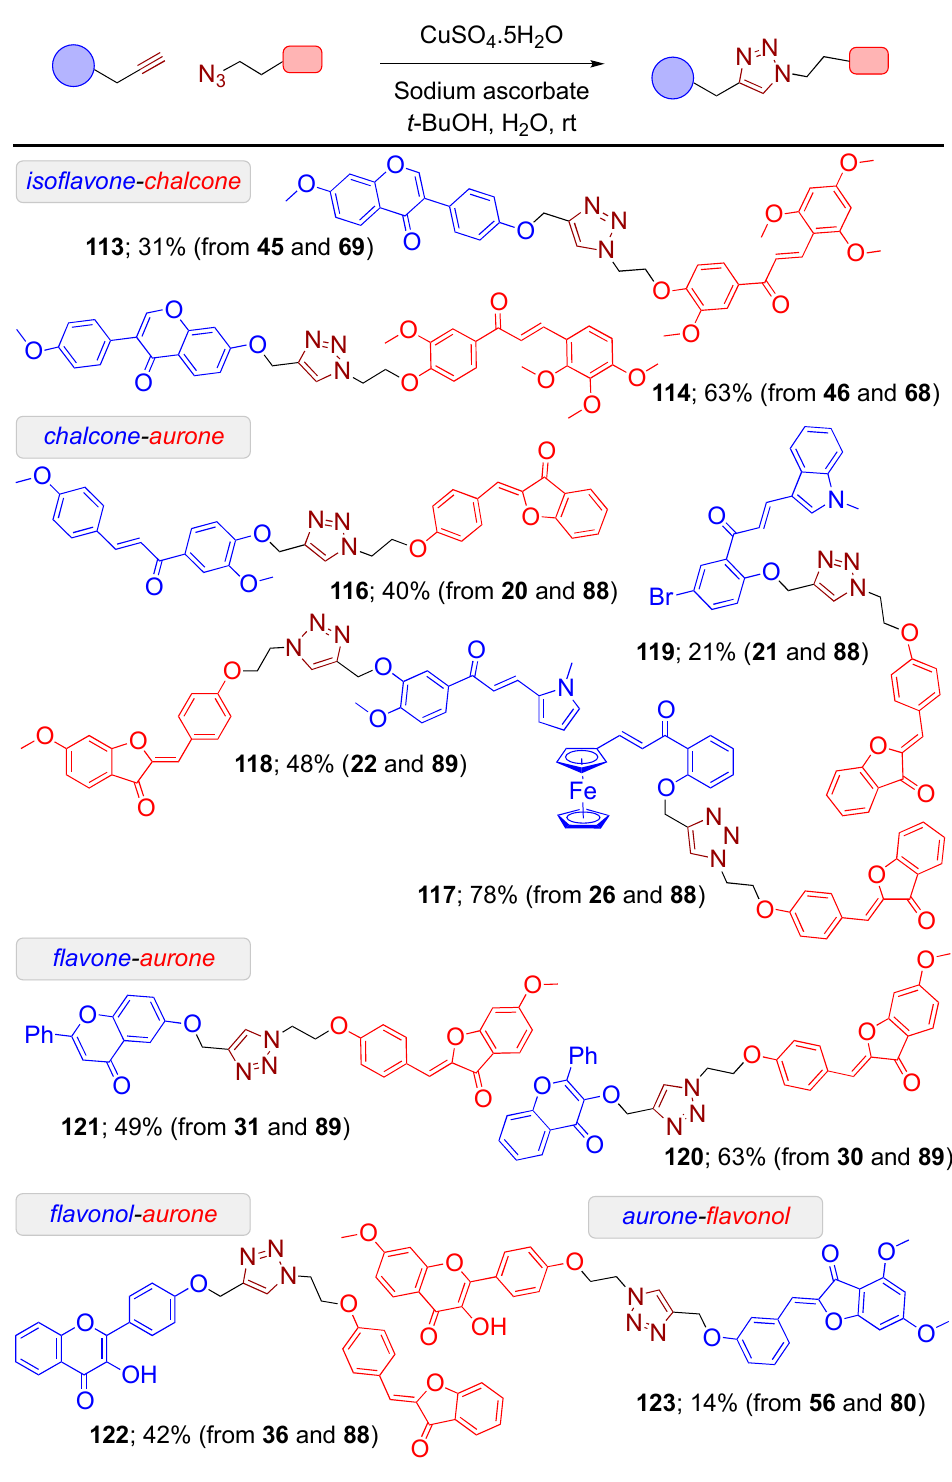
Scheme 20. Synthesis of some triazole-bridged